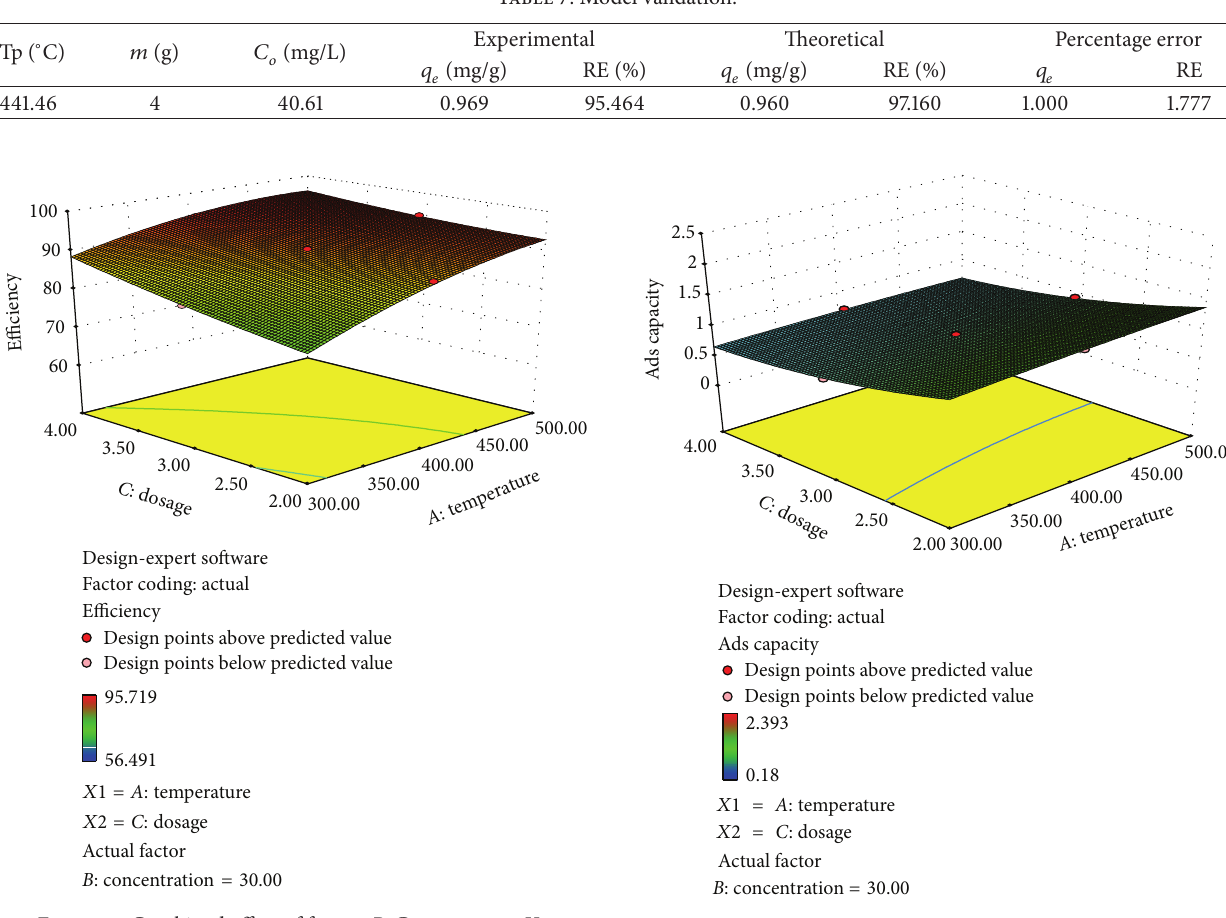
Table 7: Model validation.